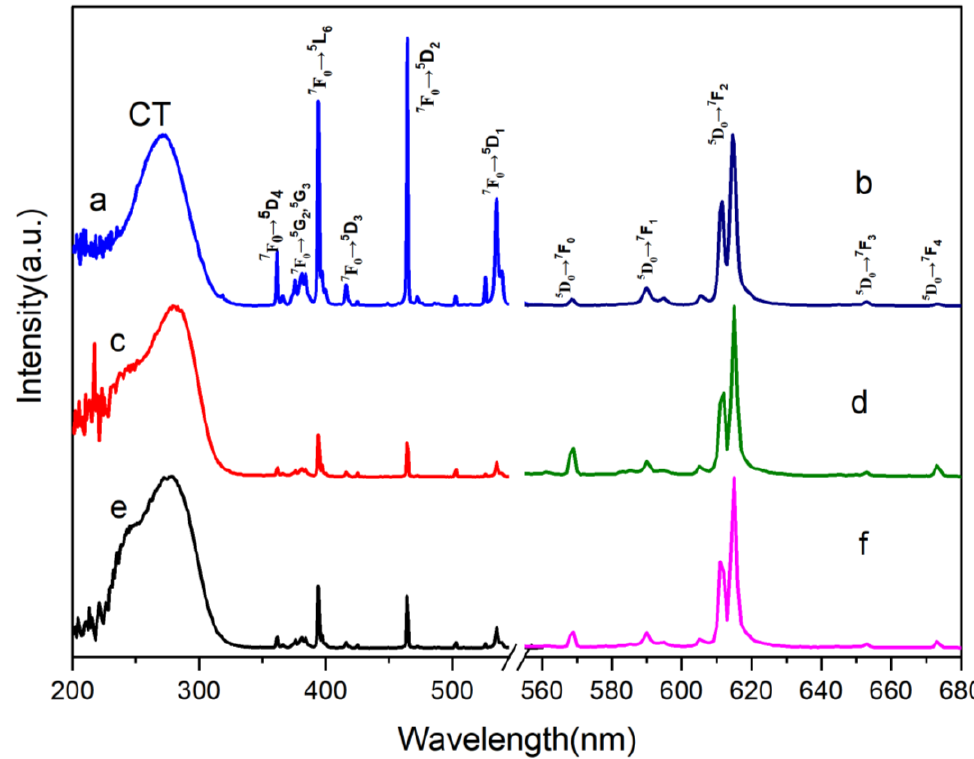
Figure 7. Excitation ( a , c , e ) and emission ( b , d , f ) spectra of SrWO 4 :Eu 3+ , SrMo 0.5 W 0.5 O 4 : Eu 3+ , and SrMoO 4 :Eu 3+.